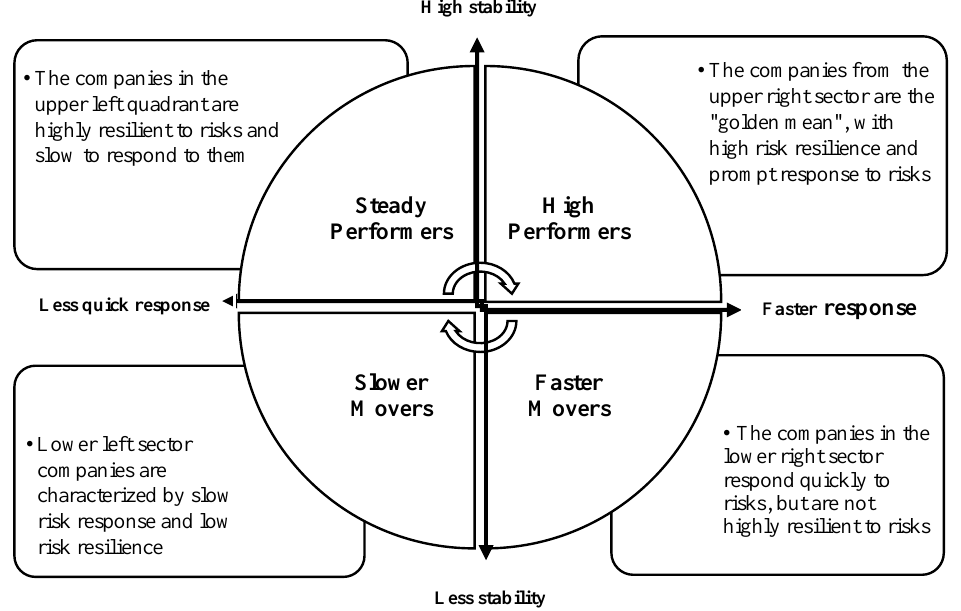
Figure 8. Construction of the matrix of risk resilience / risk